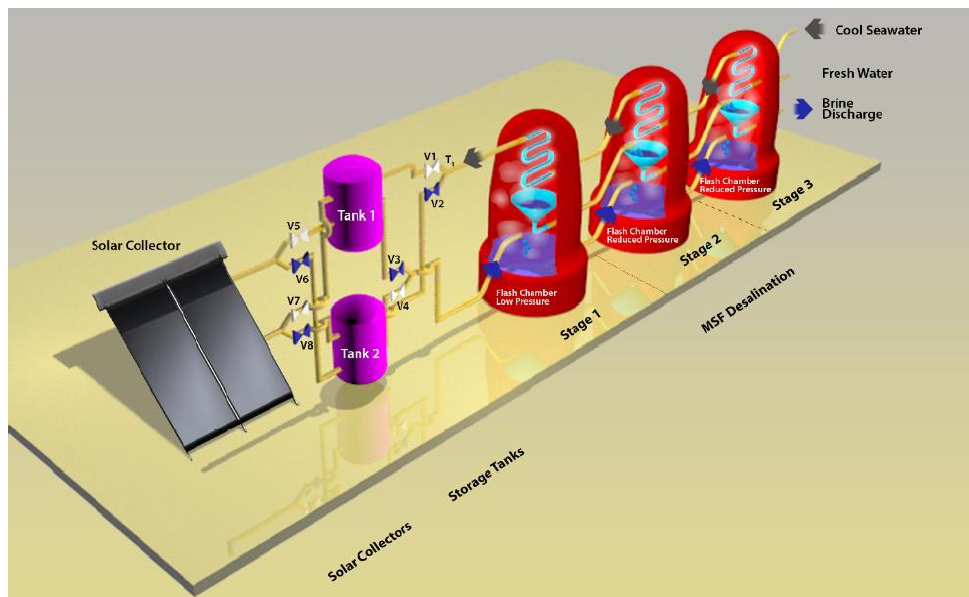
Figure 1. schematic of the design. Figure 1. Schematic of the